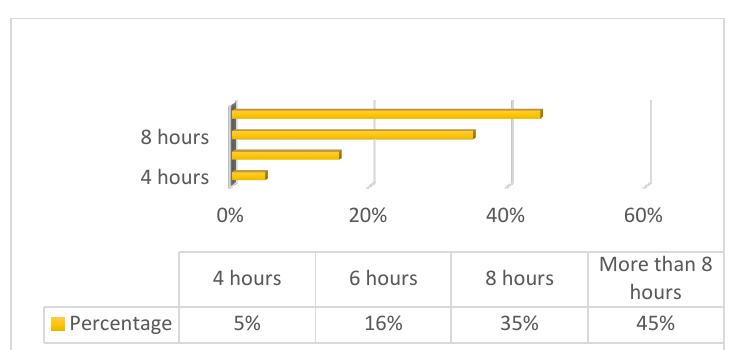
Fig. 1. Age of respondents.